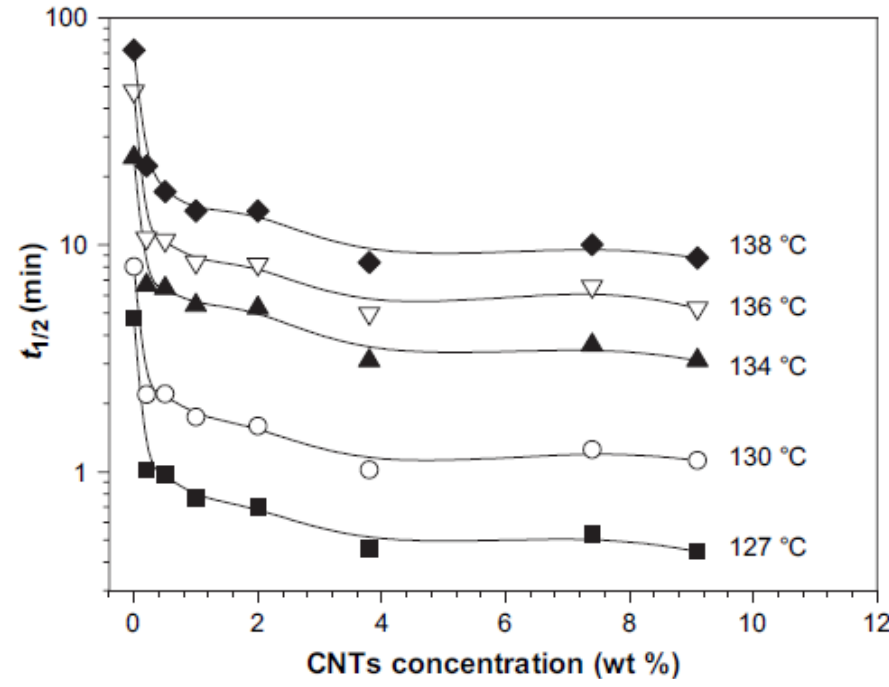
Figure 24. Changes of half crystallization time t 1/2 , of iPP/CNTs with different CNTs concentration at crystallization temperatures of 127 °C, 130 °C, 134 °C, 136 °C and 138 °C. Reproduced with permission from ref.